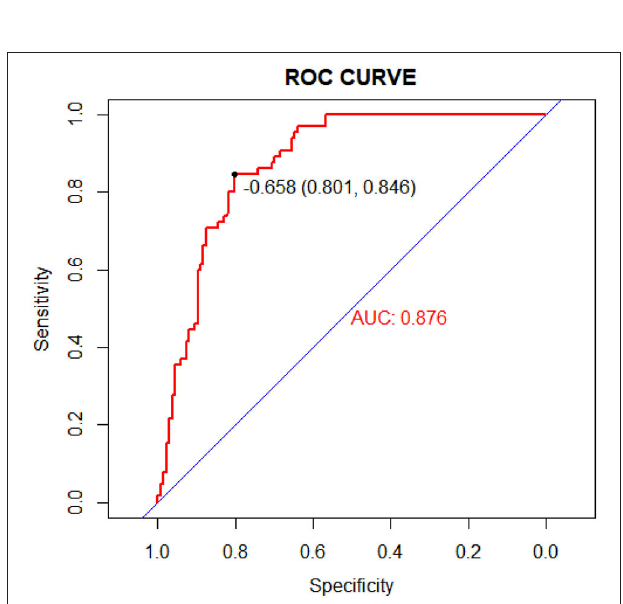
FIGURE 2 | Receiver operating characteristic (ROC) curves of the nomogram model in the training cohort.